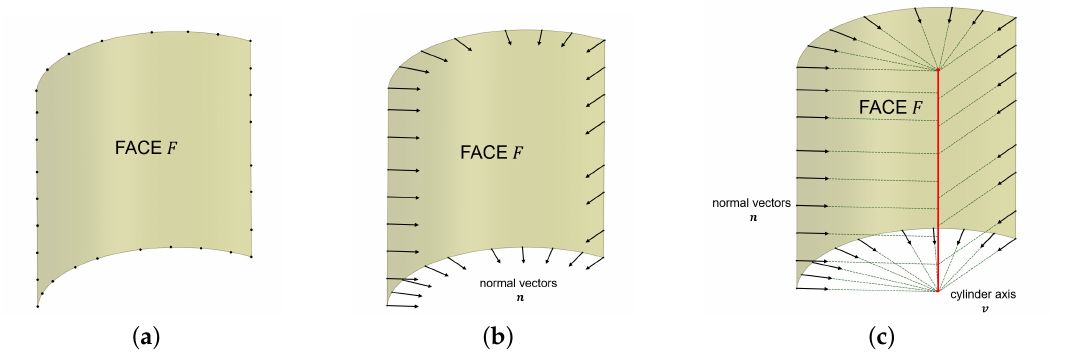
Figure 9. Cylindrical FACE geometrical filter. ( a ) Initial surface underlying FACE F , ( b ) Normal vectors (cid:126) n on surface, and ( c ) Cylinder’s axis (cid:126) v